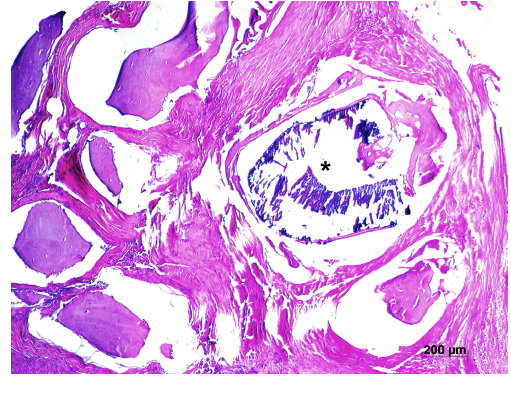
Figure 11. Lung of the dog which died due to heartworm infection showing a fragment of parasite in the lumen of an artery